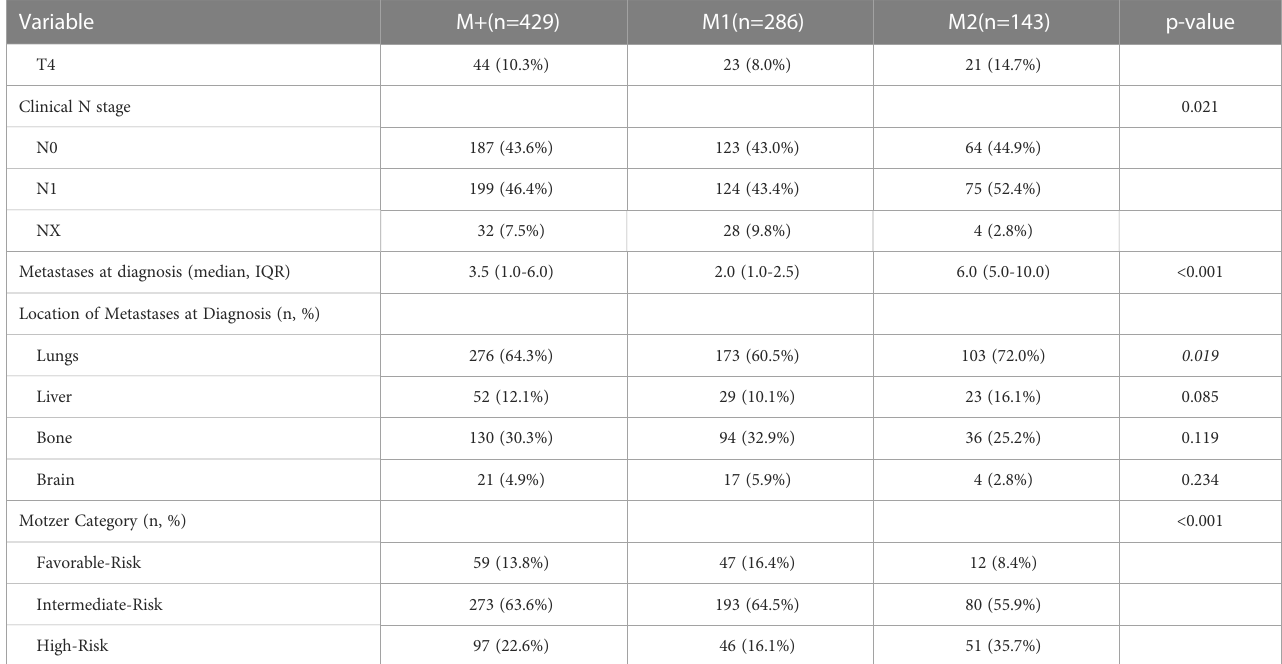
TABLE 2 Therapeutic interventions, and survival outcomes. Variable